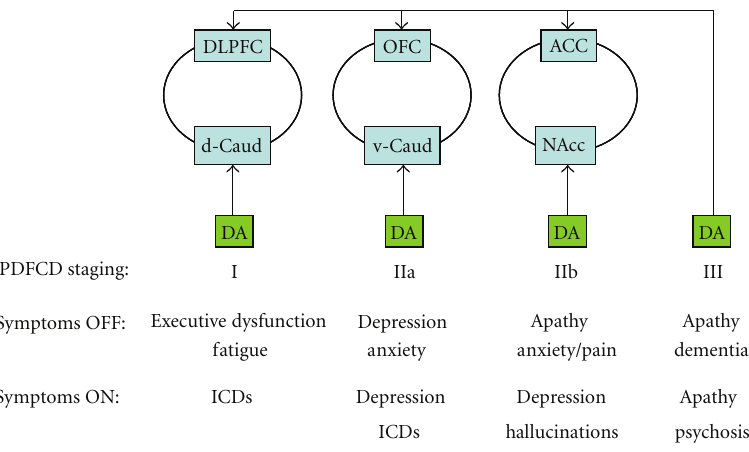
Figure 1: Parkinson’s disease-related frontostriatal cognitive dysfunction (PDFCD) staging. Three major frontostriatal loops are shown: (1) the loop connecting the dorsolateral prefrontal cortex (DLPFC) with the dorsal caudate nucleus (d-Caud), (2) the loop connecting the orbitofrontal cortex (OFC) with the ventral caudate nucleus (v-Caud), and (3) the loop connecting the anterior cingulate cortex (ACC) with the nucleus accumbens (NAcc). Dopamine (DA) projections for these loops, as well as the direct dopaminergic projection to the frontal cortex, are schematically shown. Major symptoms, OFF and ON dopaminergic treatment, are detailed. ICDs: impulse control disorders.